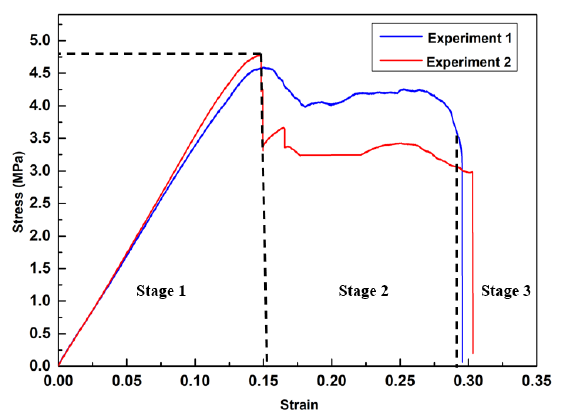
Figure 10. Experimental stress – strain curves of CS-based metamaterial units.